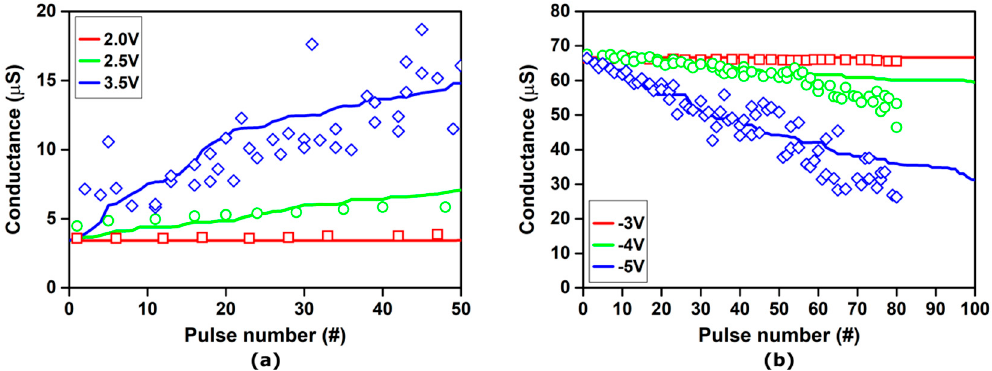
Figure 9. Experimental (symbols) and simulated (lines) conductance evolution of TiN/2 nm Ta 2 O x /35-nm TiO y /TiN RRAM stacks under the application of set pulse trains with a 100 µS width and variable amplitude. ( a ) Set operation: (red) 2 V; (green) 2.5 V; (blue) − 3.5 V. ( b ) Reset operation: (red) − 3 V; (green) − 4 V; (blue) − 5 V.